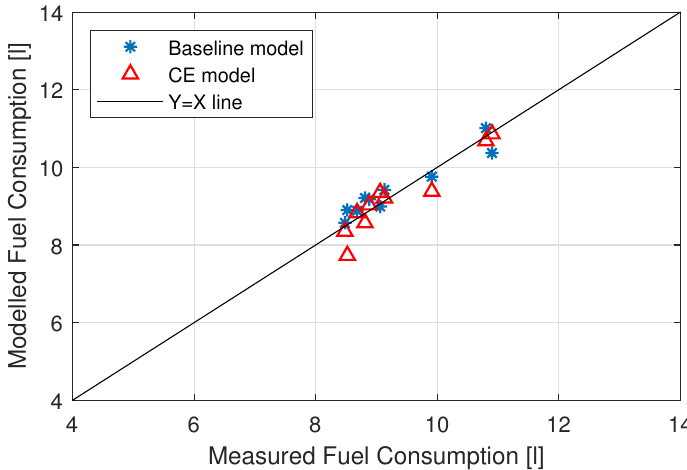
Figure 7. The diesel HGV’s modelled and measured fuel consumption (litres) in different DCs.